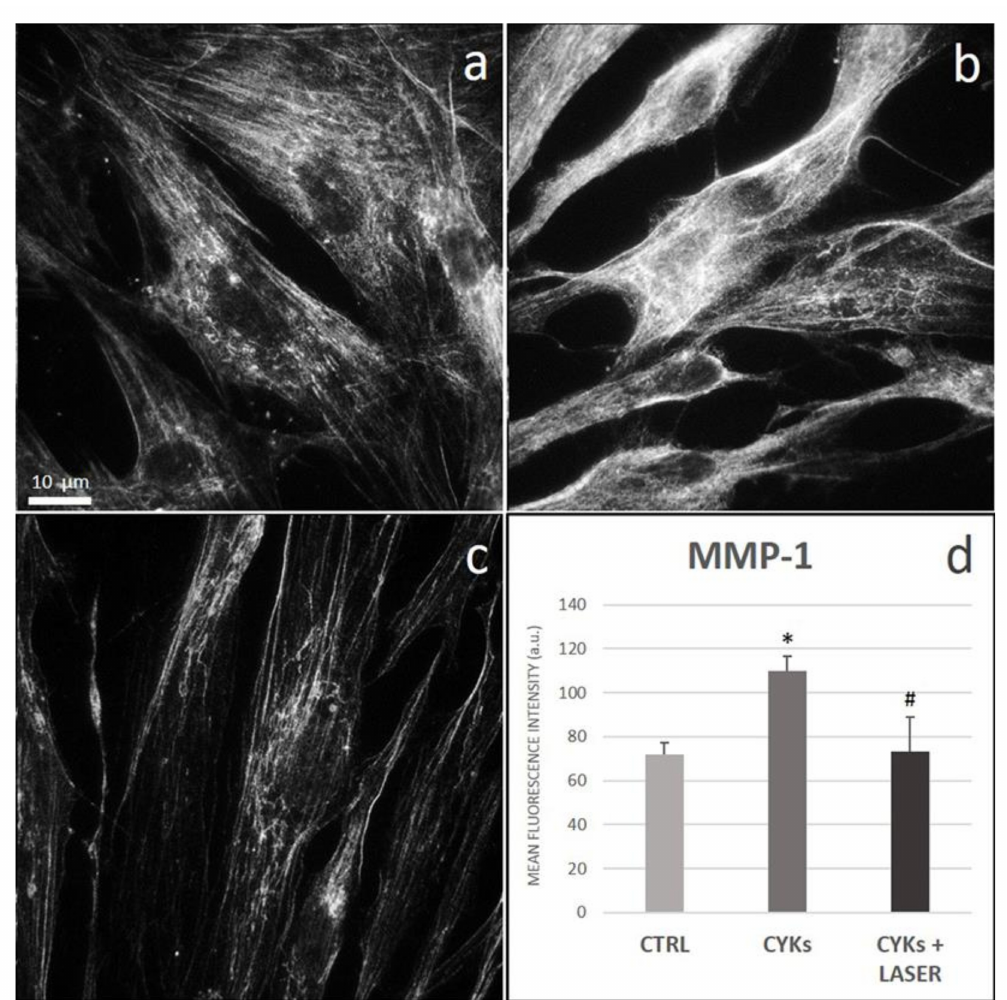
Figure 9. Effect of laser treatment on MMP-1 expression and distribution. Microscopy analysis of MMP-1 expression evaluated by immunofluorescence (magnification 100 × ) on NHDF in basal conditions (CTRL; panel ( a )), stimulated with IL-1 β and TNF- α for 48 h (CYKs; panel ( b )), stimulated with IL-1 β and TNF- α for 48 h and then exposed to laser treatments (3 treatments, repeated once a day, for 3 consecutive days) (CYKs + Laser; panel ( c )). Bar = 10 µ m. The histogram reports the mean pixel intensity, acquired by ImageJ software after appropriate thresholding and subsequent image masking (panel ( d )). * p < 0.05 CYKs group vs. CTRL group; # p < 0.05 CYKs + Laser group vs. CYKs group ( n =